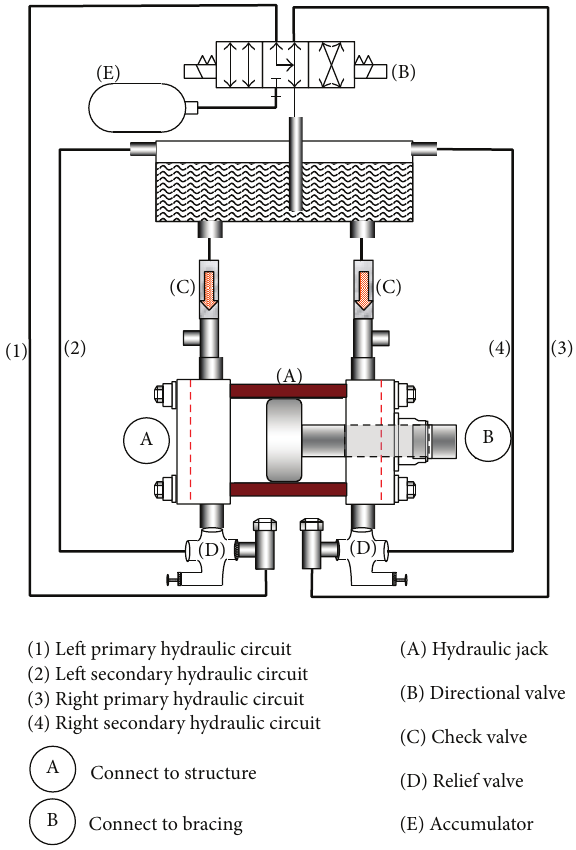
Figure 1: Framework of Accumulated Semiactive Hydraulic Device [17].